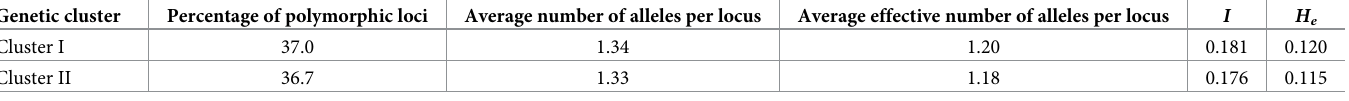
Table 1. Descriptive statistics of genetic diversity within two population clusters of sideoats grama ( Bouteloua curtipendula ). Genetic cluster Percentage of polymorphic